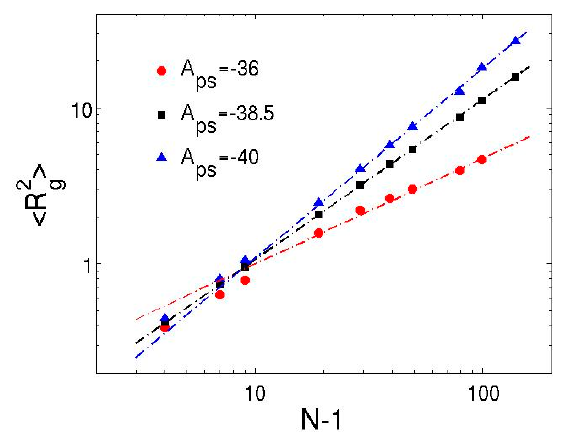
Figure 3. Log–log plot of mean-square radius of gyration as a function of the number of Hookean springs in each chain for different solvent quality. The dash-dot lines correspond to the power-law fittings of simulation data. The error bars are smaller than the symbols.